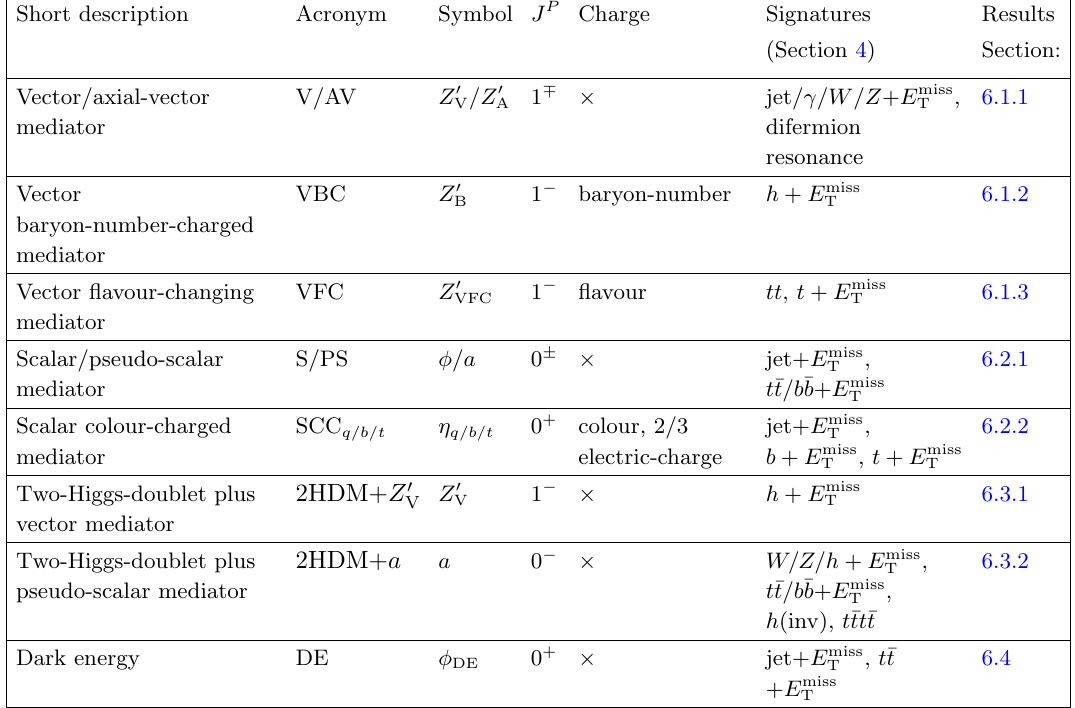
Table 1. Summary of the mediator-based simpli(cid:12)ed models considered in this paper, along with the associated model acronym (2 nd column, de(cid:12)ned in the text) and mediator symbol (3 rd column) used throughout. The 4 th and 5 th columns indicate the quantum numbers of the mediator. The ‘ ’ indicates the cases where no other charge than the new mediator’s interaction is present. The (cid:2) 6 th column indicates the (cid:12)nal-state signatures (details in section 4) and the 7 th column gives the reference to the interpretation.